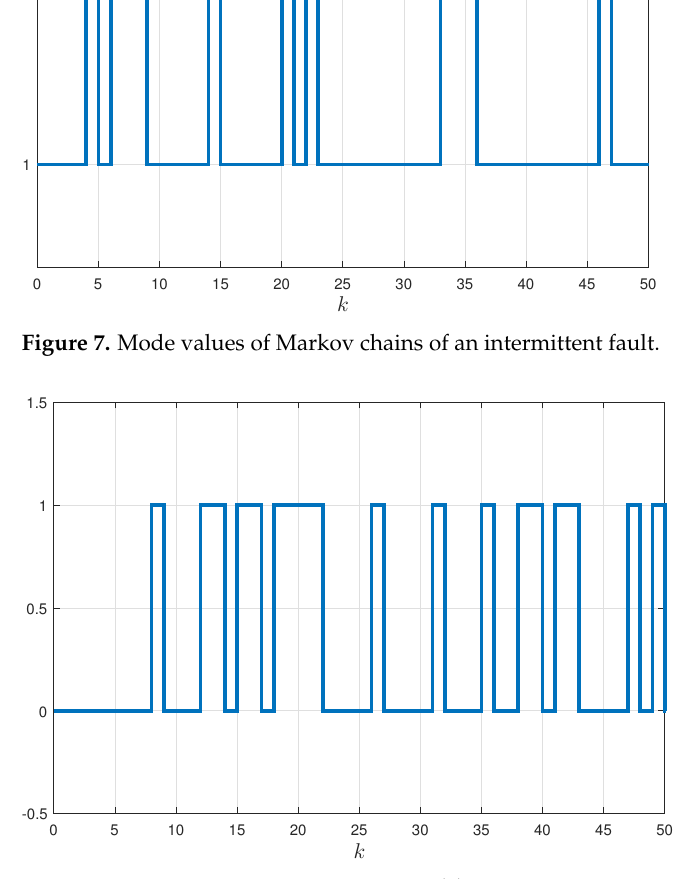
Figure 8. Bernoulli distribution variable β ( k ) .